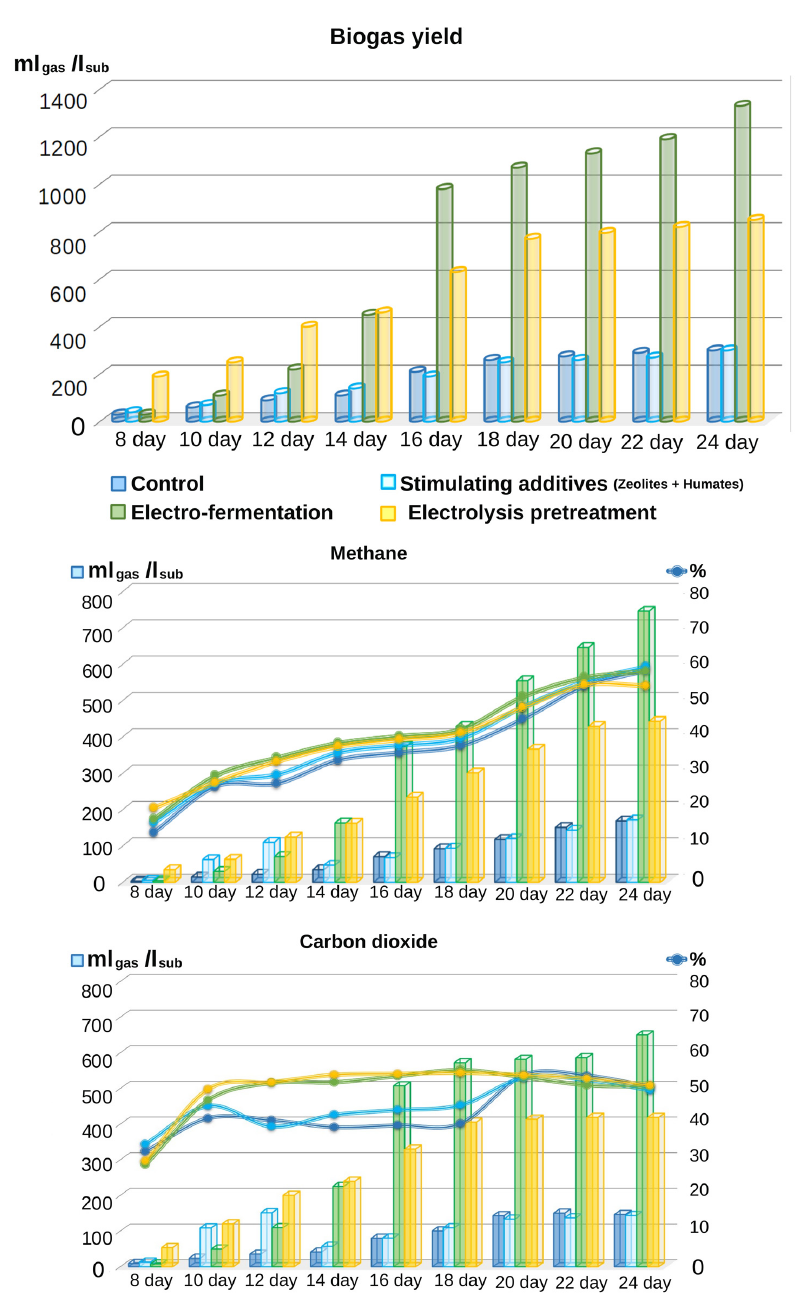
Figure 4. Biogas and methane yields in a series of experiments conducted on the intensification of anaerobic digestion of clariid catfish droppings.